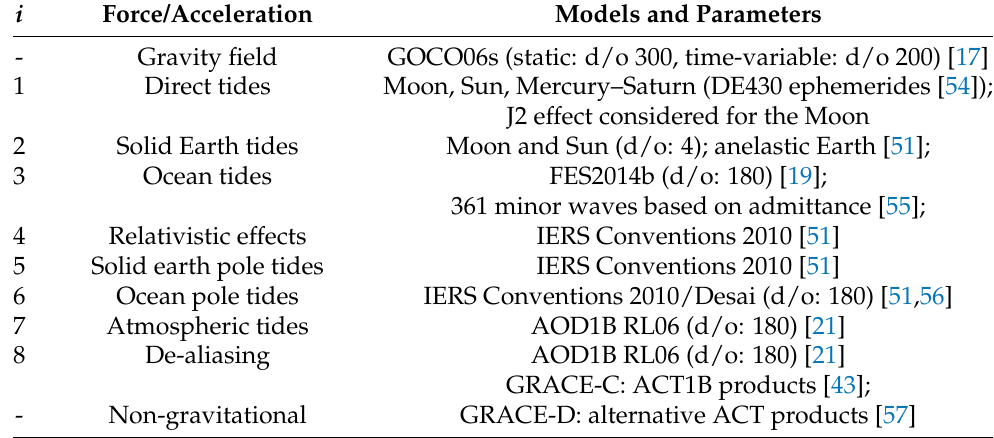
Table 1. Force/acceleration modeling standards of the LUH-GRACE-FO-2020 time series. d/o: indicates the applied maximum degree/order of the spherical harmonic coefficients. Iterator i refers to Equation